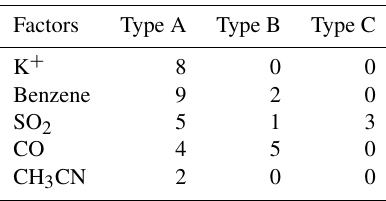
Table 5. The statistics of the days for the highest factors correlated with particulate chloride in different air mass